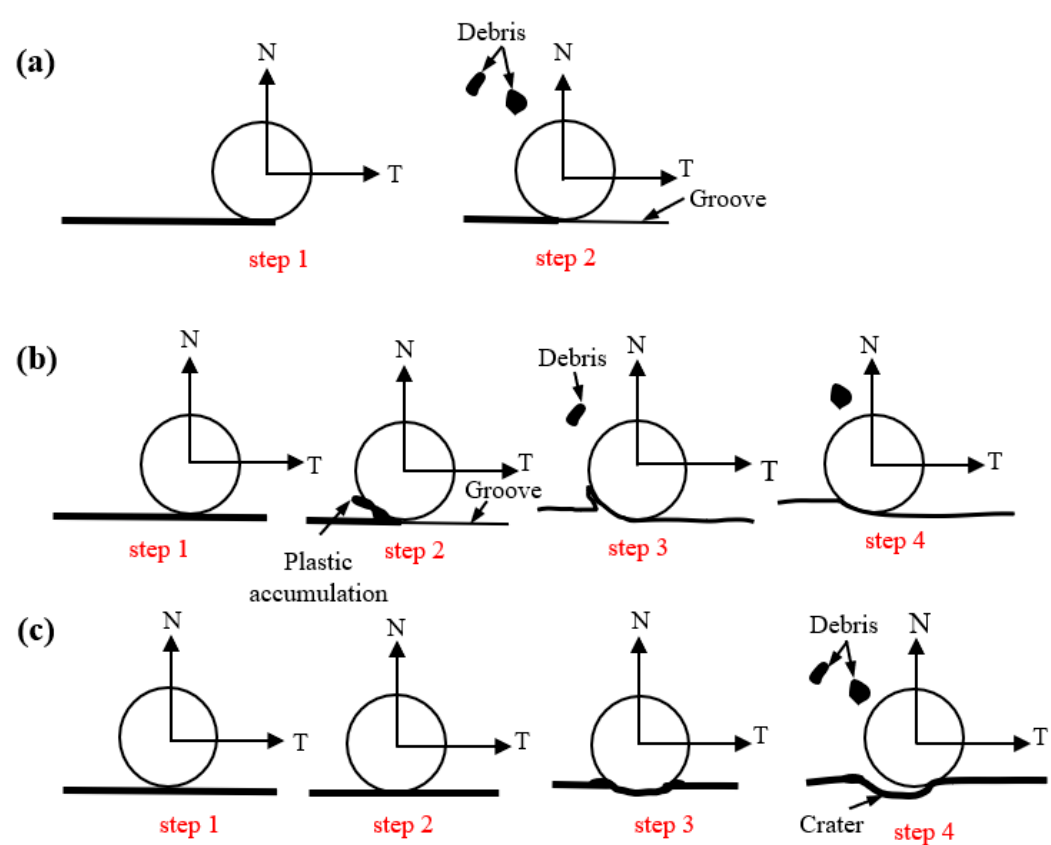
Figure 7. Diagram of 304 stainless steel erosion wear failure process. ( a ) Schematic diagram of abrasive wear process, ( b ) Schematic diagram of ploughing wear process and ( c ) schematic diagram of crater wear process.